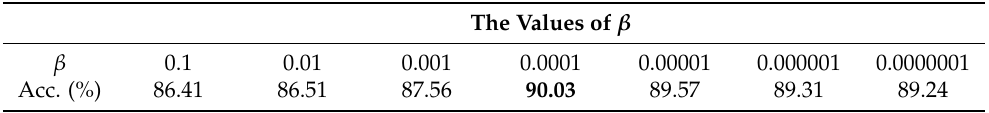
Table 5. Evaluation of different β values on the RAF-DB dataset. When setting β = 0.0001, the performance is the